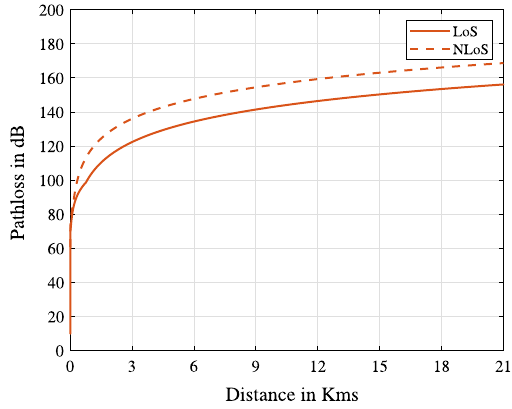
Fig. 2 Path loss versus distance for the simulation assumptions in Table 1